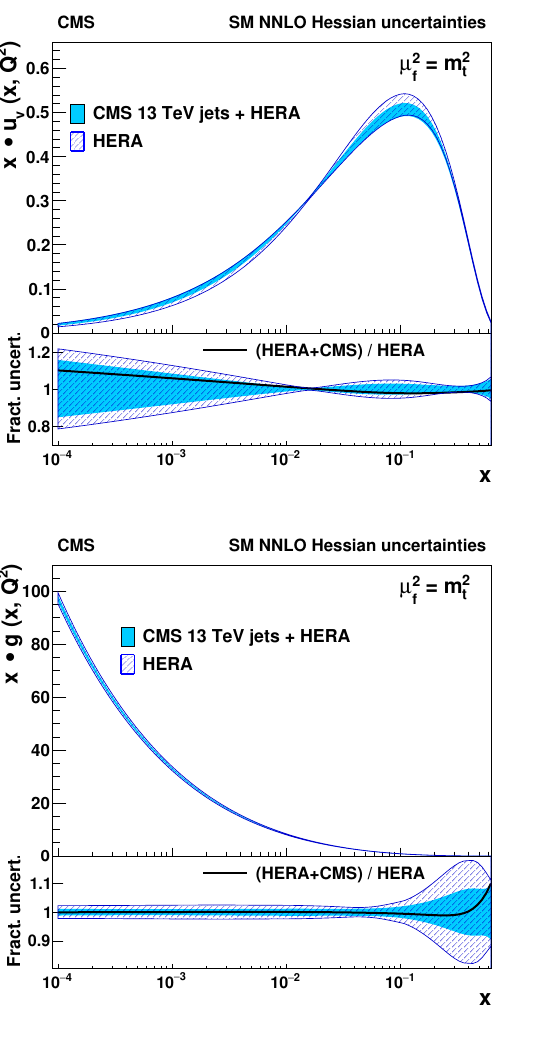
Figure 3 . The u -valence (upper left), d -valence (upper right), gluon (lower left), and sea quark (lower right) distributions shown as a function of x at the scale µ represents the results of the NNLO fit using HERA DIS and the CMS inclusive jet cross section at √ s = 13 TeV (using the HERA DIS data only). The PDFs are shown with their total uncertainty. The prediction for the inclusive jet cross section is obtained using NNLO interpolation grids. In the lower panels, the comparison of the relative PDF uncertainties is shown for each distribution. The line corresponds to the ratio of the central PDF values of the two variants of the